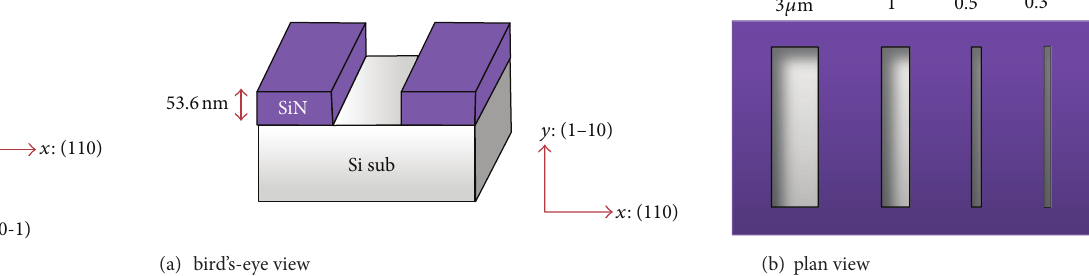
Figure 1: (a) Cross-sectional view of Si with patterned SiN structures and (b) plan views of etched L&S pattern.